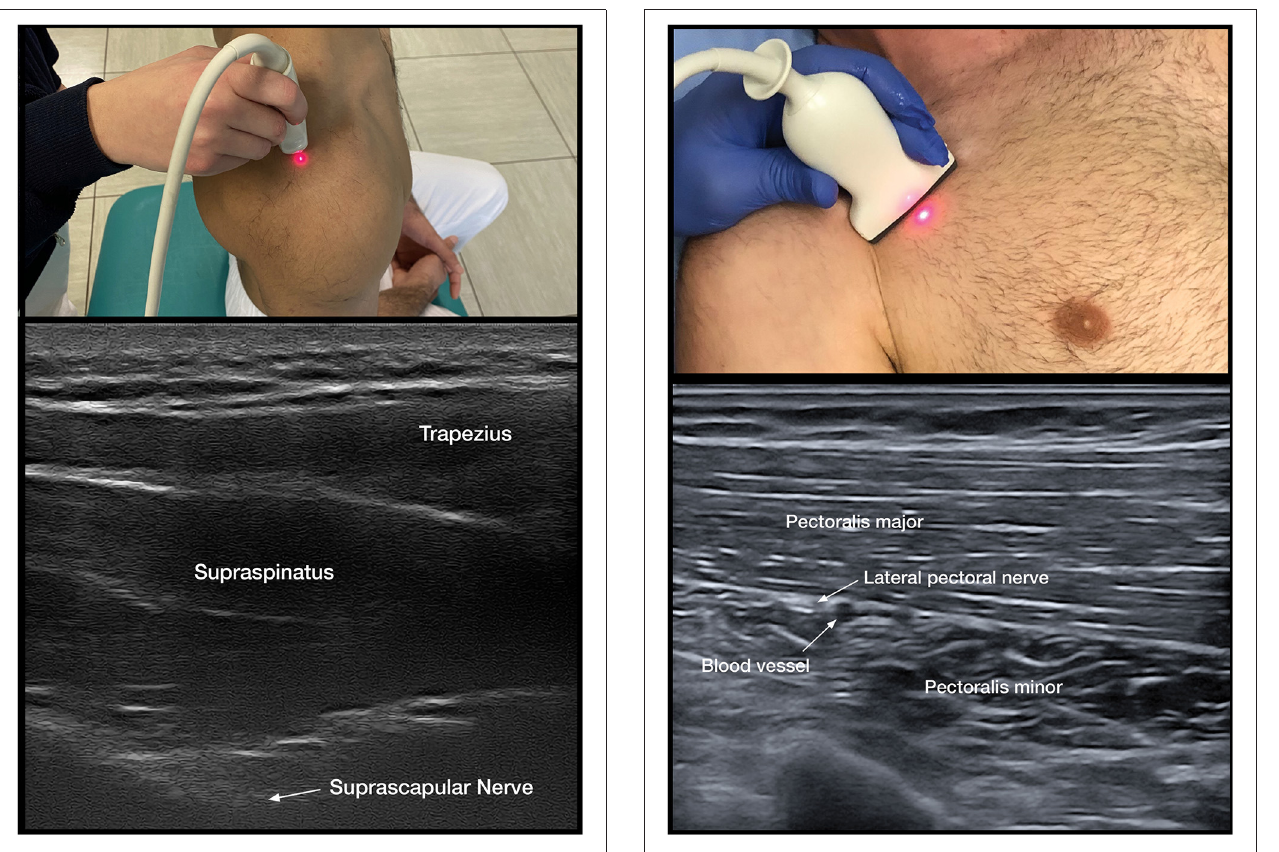
FIGURE 2 | Suprascapular nerve block. FIGURE 3 | Lateral pectoral nerve